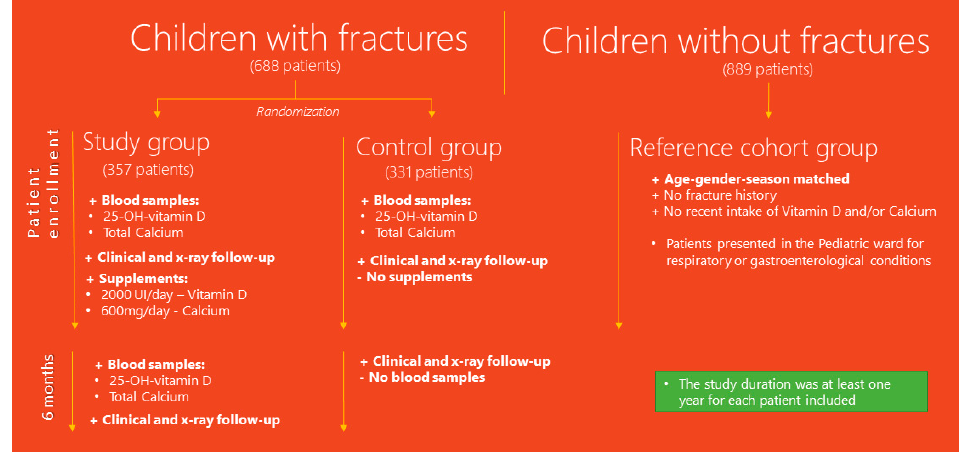
Figure 1. Flow diagram describing the patient selection process of the study group, control group, and reference cohort. The study duration was at least one year for each patient included.